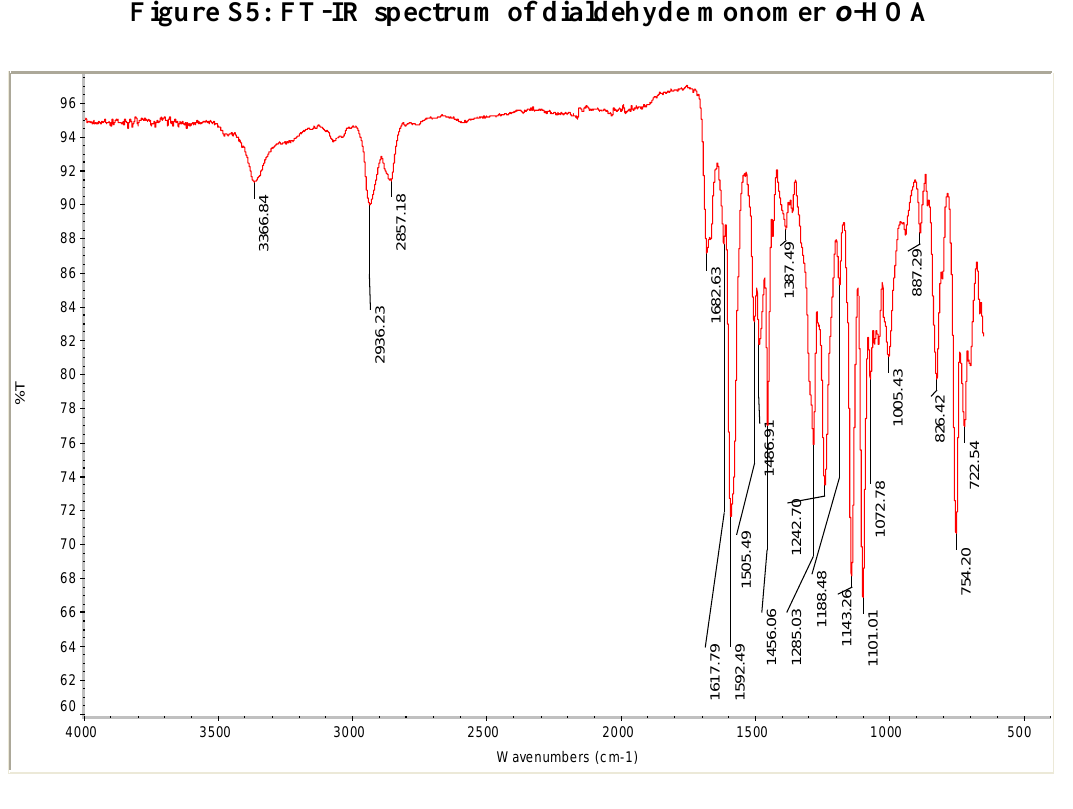
Figure S6: FT-IR spectrum of Schiff base polyether P o